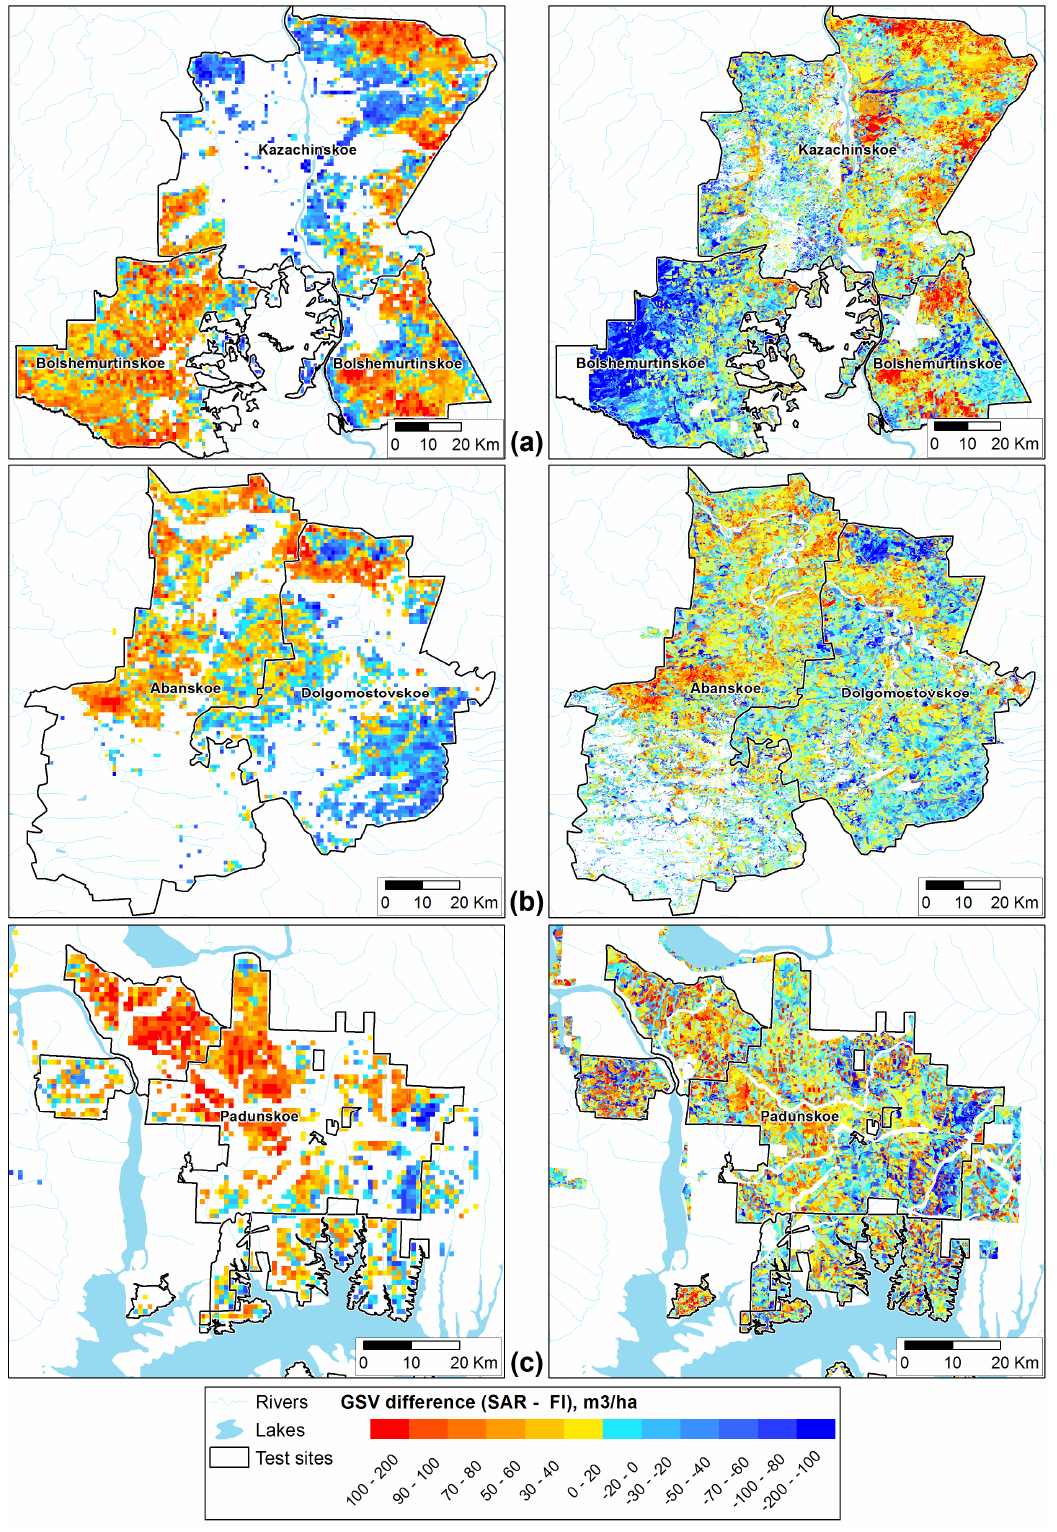
Figure 5. Difference of the 1 km GSV ( left ) and 25 m GSV ( right ) maps with respect to the inventory map for the test sites of Kazachinsk and Bolshemurtinsk ( a ), Abansk and Dolgomostowsk ( b ), and Padunsk ( c